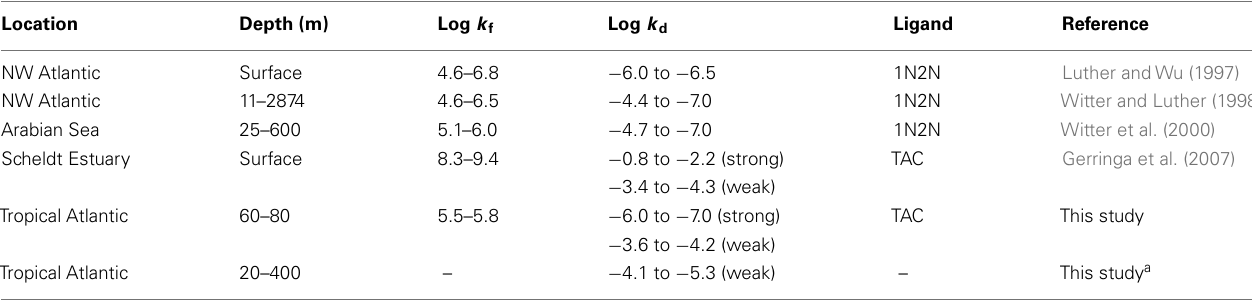
Table 2 | CSV-KIN: summary of FeL kinetic data for natural ligands in seawater from the literature.